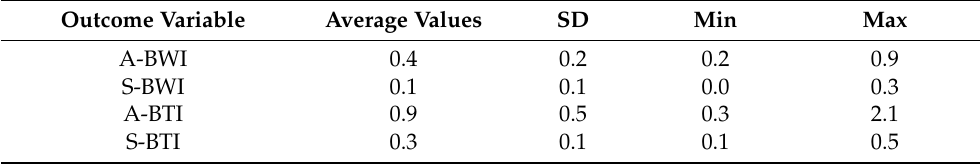
Table 2. Descriptive statistics of outcome variables over the 24 h EMG recording (mean values; standard deviations; min; and